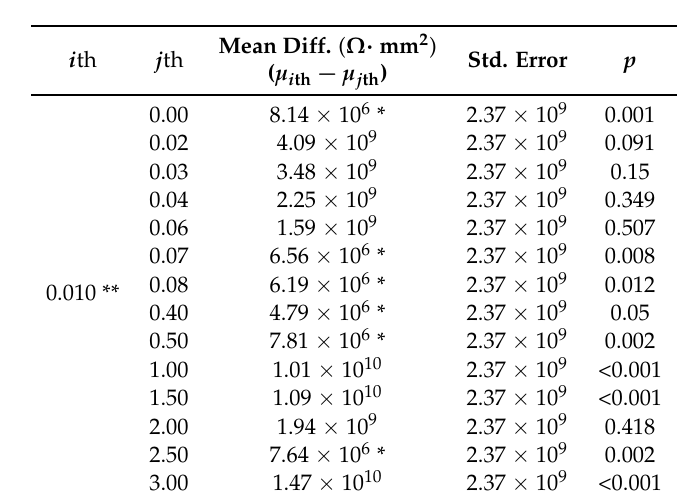
Table 8. LSD Test mean comparison: between i th concentration and j th